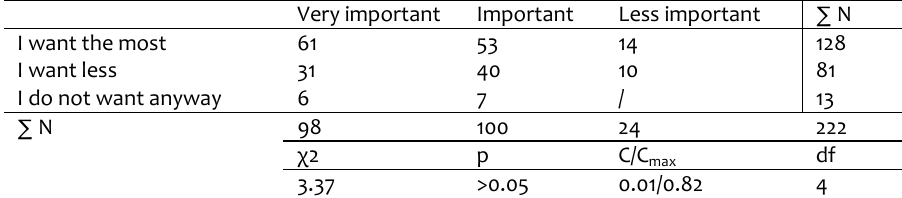
Table 3: Social status of students and importance of sports Very important Important Less important